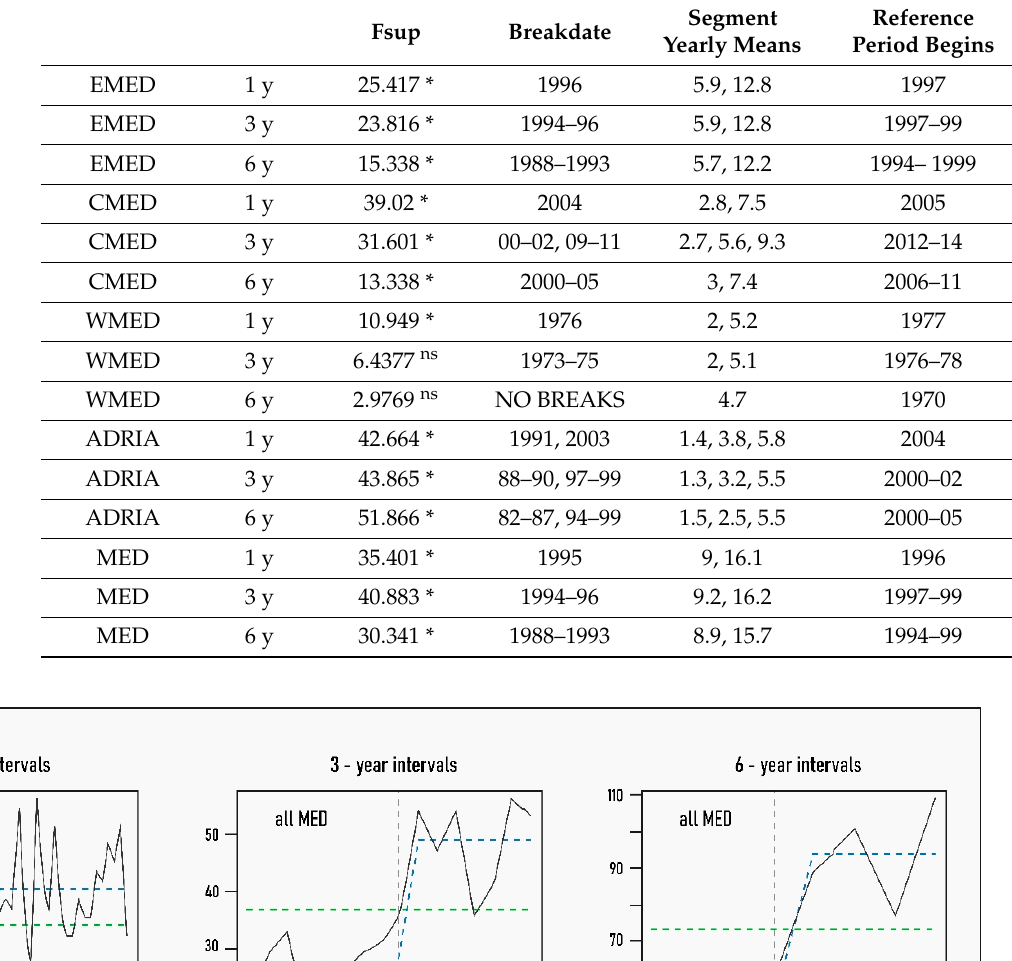
Table 2. Results of the breakpoint structural analysis with the reduced dataset: Fsup is the modified F statistic testing the null hypothesis of no breakpoints; * indicates the detection of a statistically significant change ( p < 0.05) in the mean values of the time series; ns stands for not significant; and segment yearly means are the fitted mean values of new NIS before and after the breaks (converted from the 3-y and 6-y values by simple division). Dataset reduced.